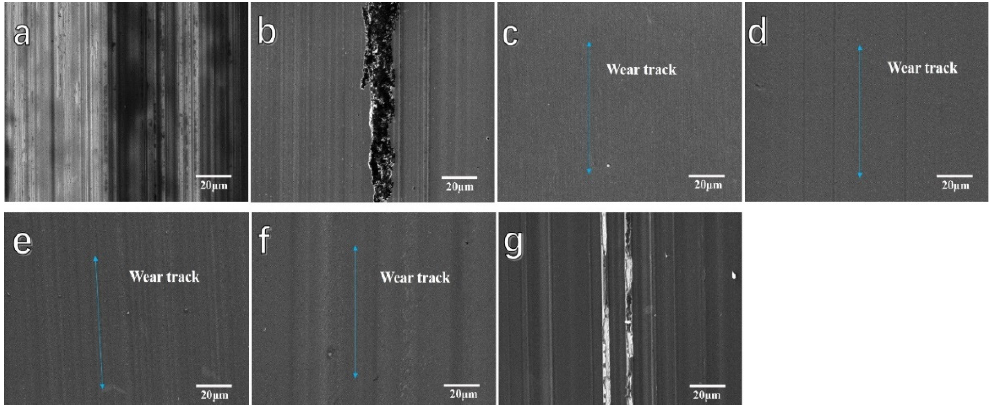
Figure 7. SEM images of wear tracks on the surface of DLC coatings lubrication with different content of Cu nanoparticles in PAO6: ( a ) 0 wt.%, ( b ) 0.05 wt.%, ( c ) 0.1 wt.%, ( d ) 0.3 wt.%, ( e ) 0.5 wt.%, ( f ) 1.0 wt.%, ( g ) 1.5 wt.%.